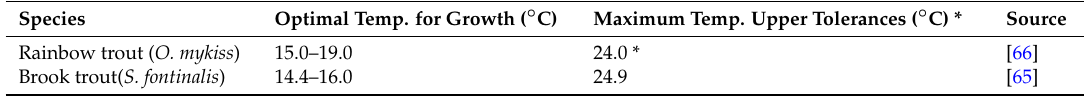
Table 4. Optimal and maximum temperature for